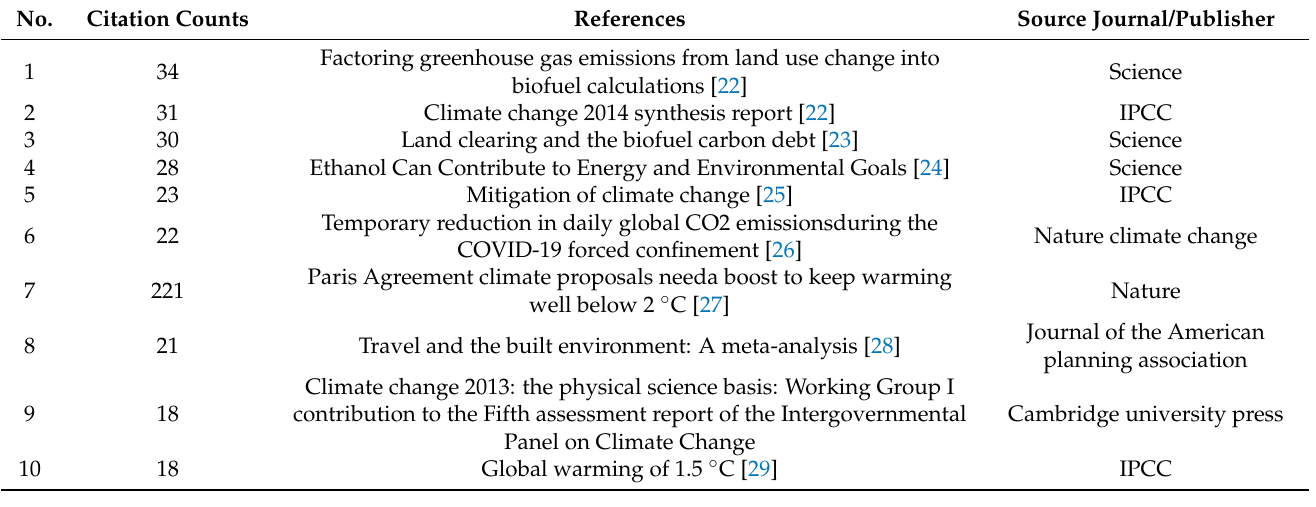
Table 6. Top 10 cited references.